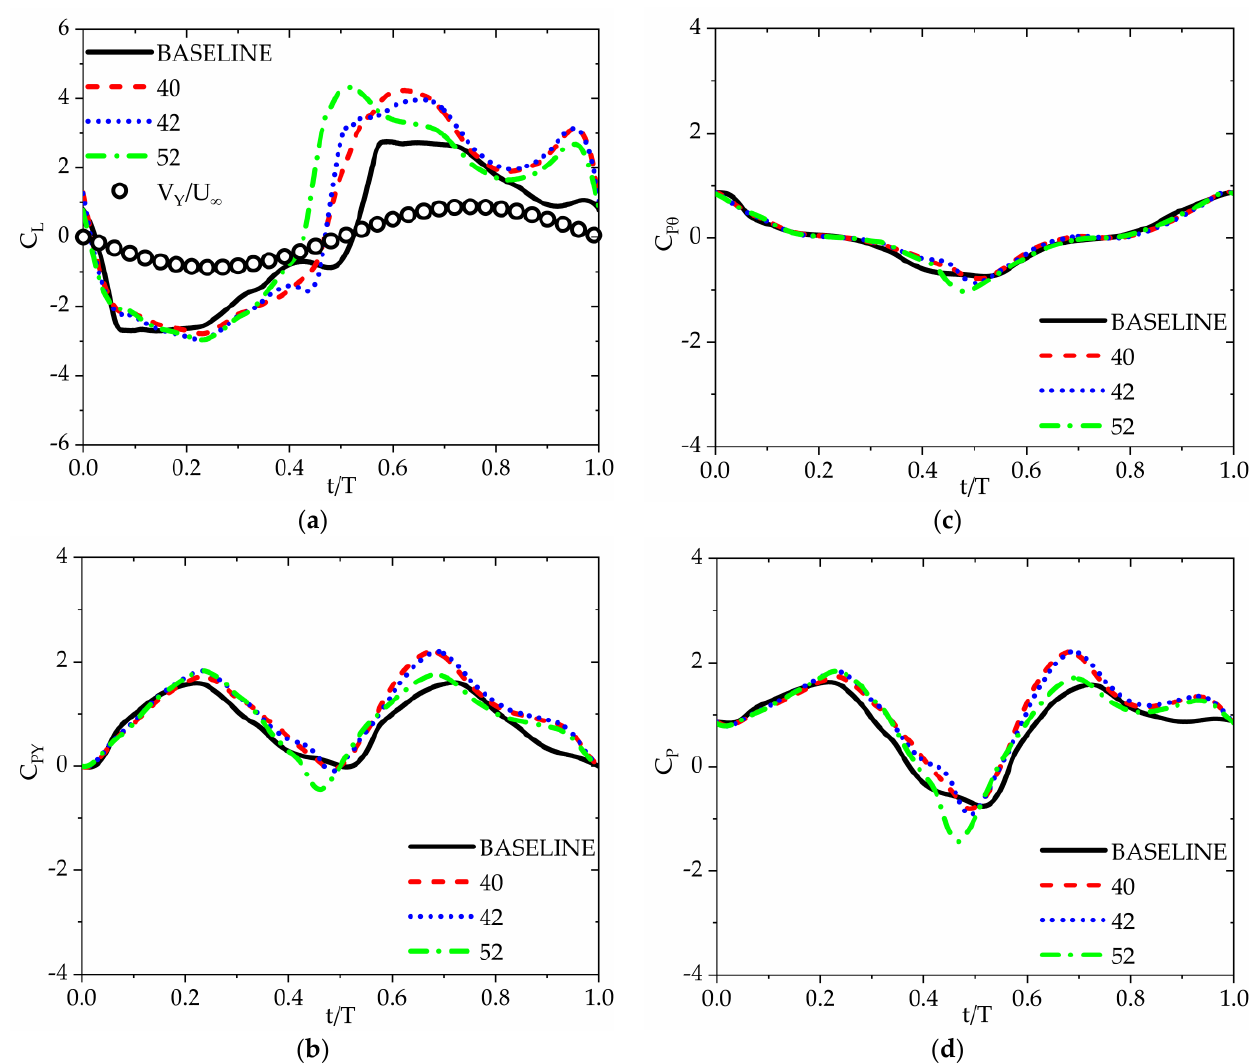
Figure 18. A comparison of the instantaneous lift and power coefficients of an oscillating hydrofoil with an upstream deflector with different tilt angles. ( a ) Lift coefficient. ( b ) Heave power coefficient. ( c ) Pitch power coefficient. ( d ) Net power coefficient.